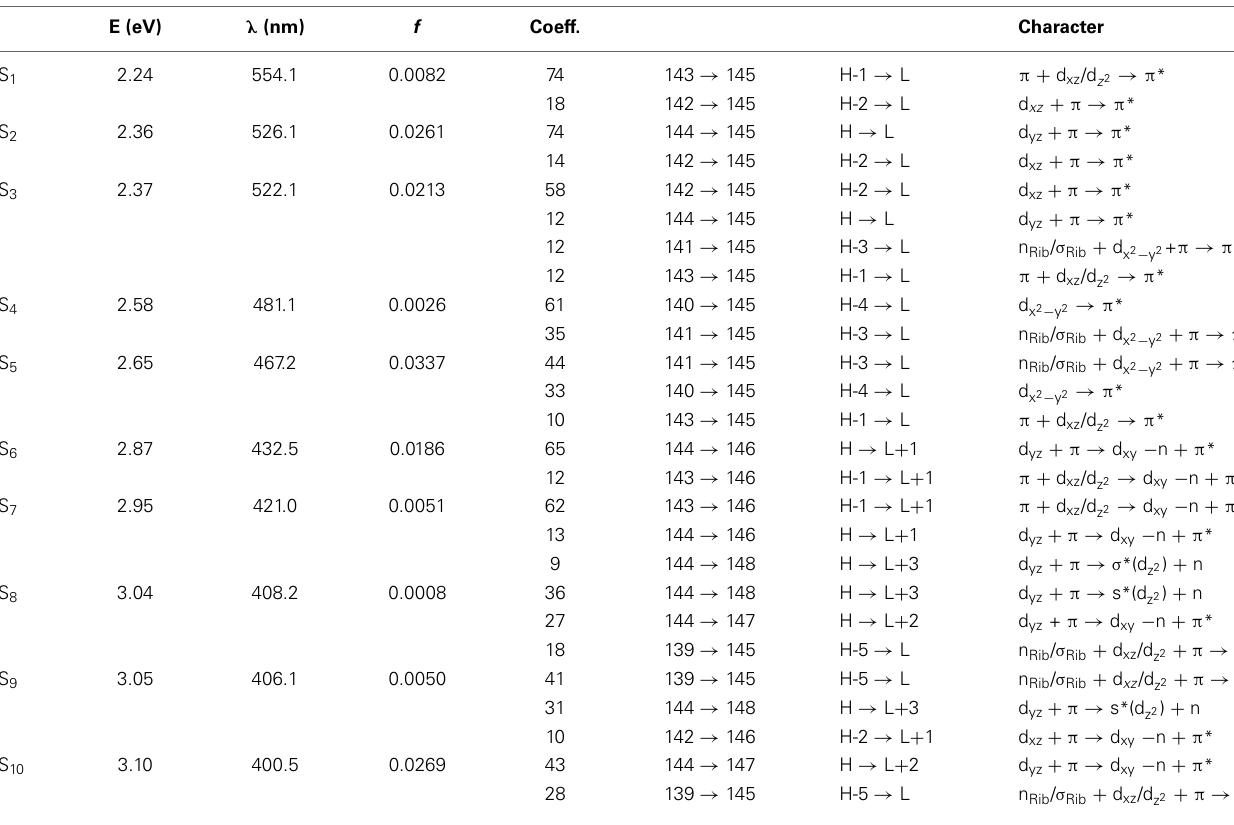
Table 1 | The lowest ten singlet states for RibCbl received from TDDFT/TZVP gas phase calculations. E (eV)